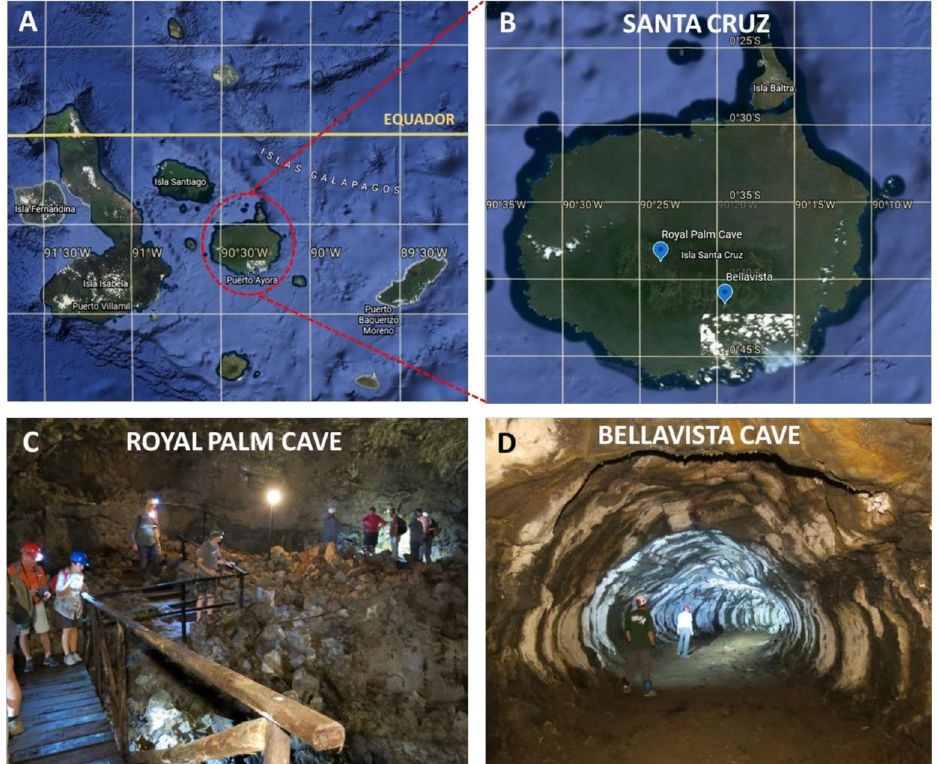
Figure 1. Location of the lava tubes: ( A ) Map of Galapagos Islands (Ecuador) with the location of Santa Cruz Island (red circle); ( B ) map of Santa Cruz Island (Galapagos, Ecuador) with the location of the lava tubes. Source: Google Maps (2020). Galapagos Islands. Retrieved from https: // goo.gl / maps / uWE17T5mHQiQKGCM6. ( C ) General view of Royal Palm Cave; ( D ) general view